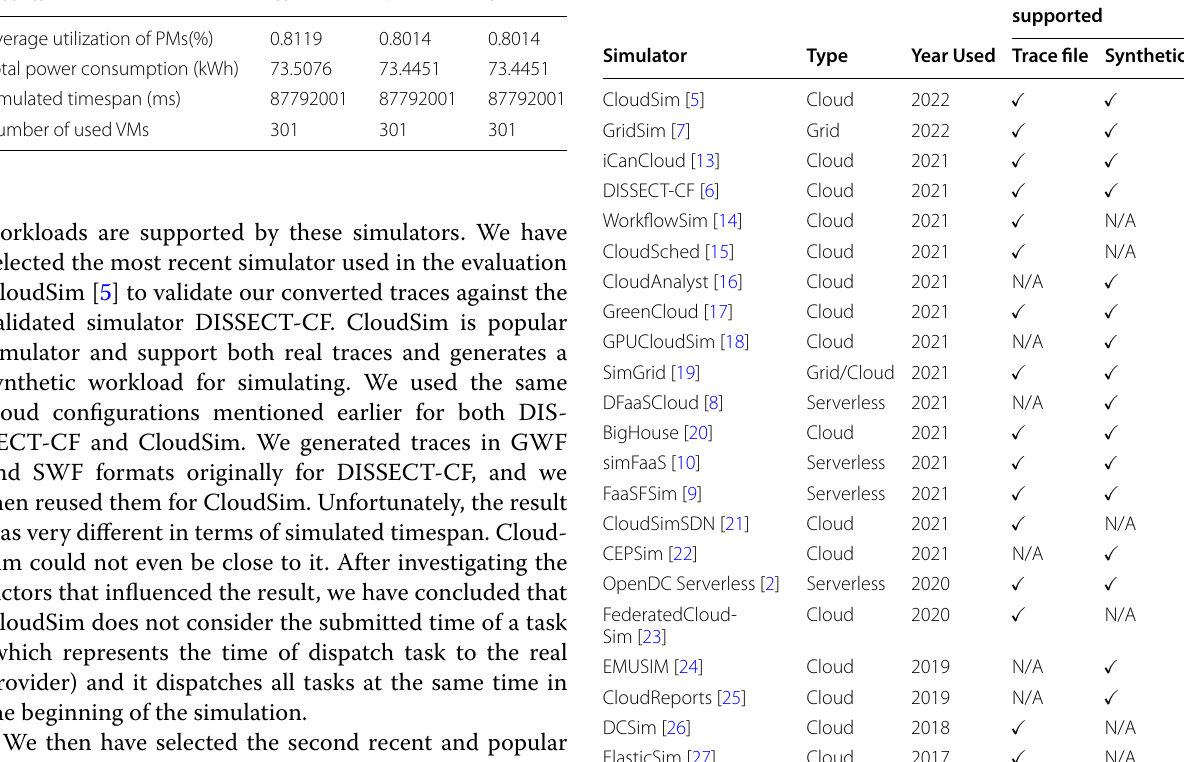
Table 3 Simulating 20 k jobs with different formats Metrics CSV GWF SWF Average utilization of PMs(%)